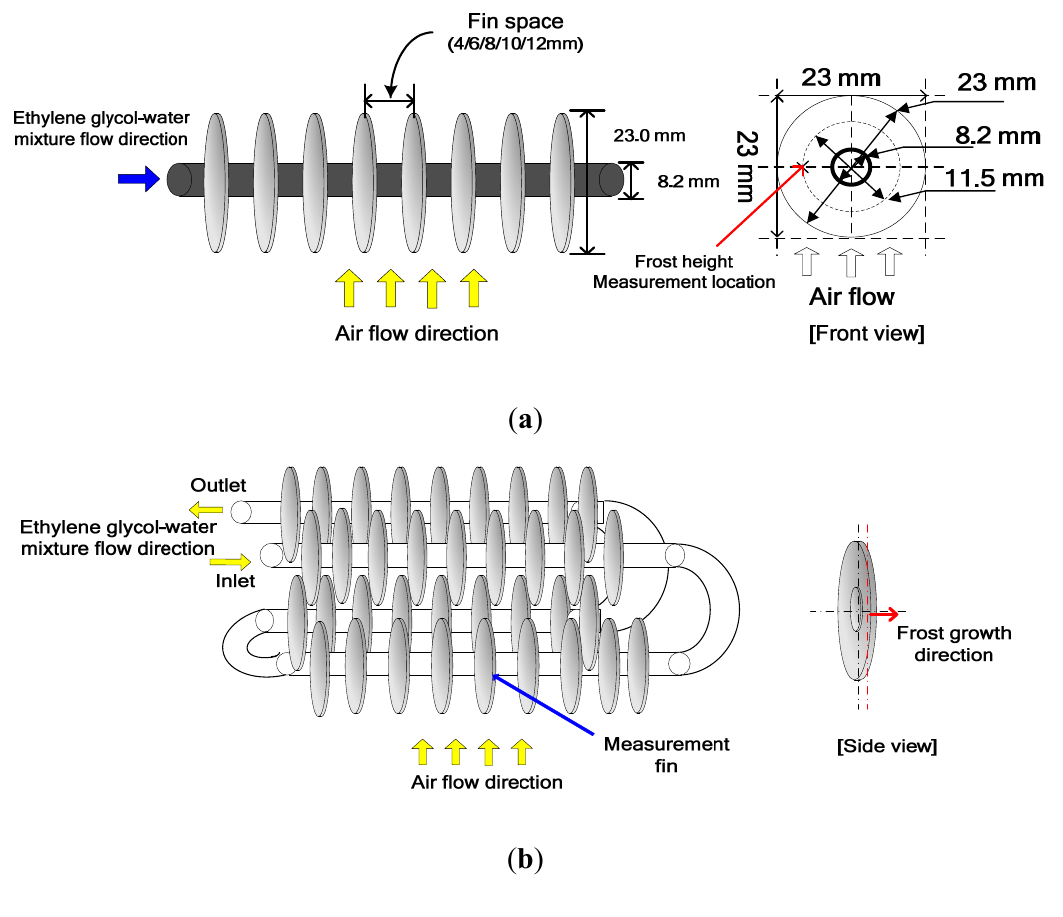
Figure 2. Specifications and configuration of the round plate fin-tube heat exchanger. ( a ) Round plate fin and tube specification; ( b ) Heat exchanger configuration and frost height measurement location.